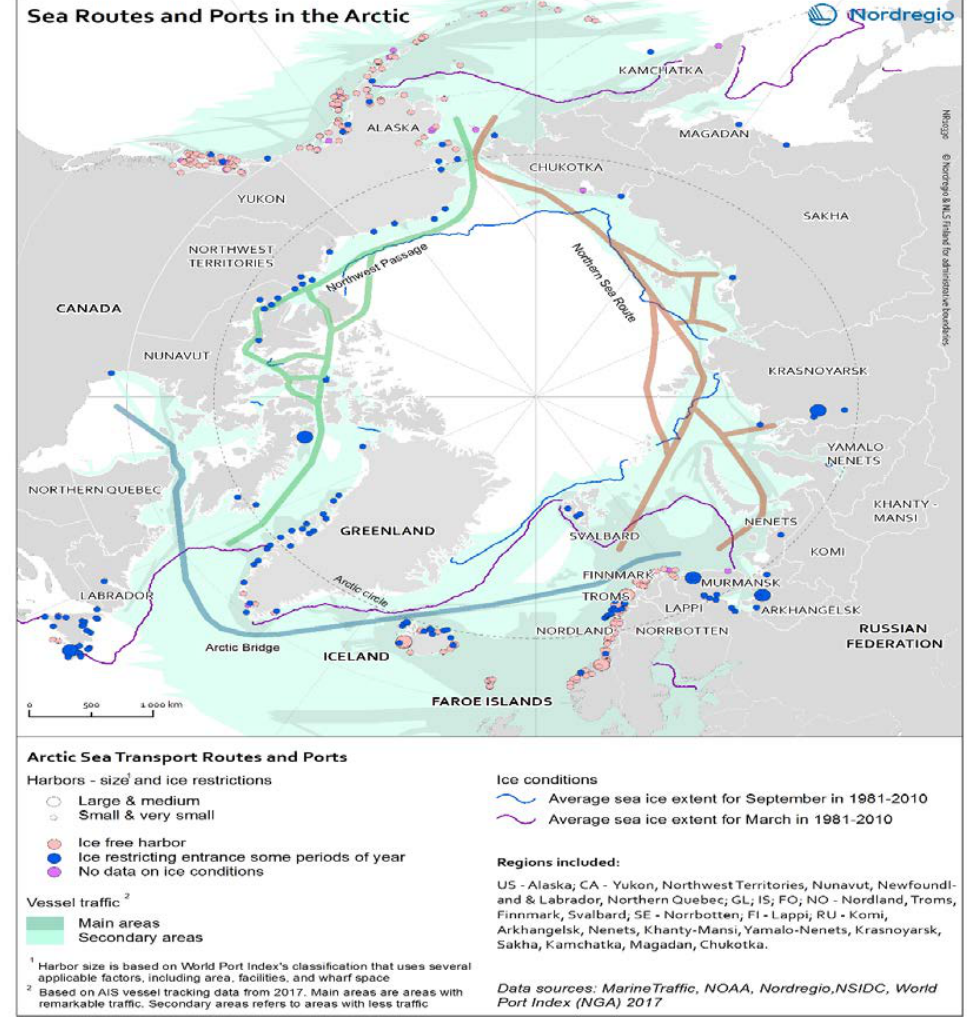
Figure 1. Sea routes and ports in the Arctic. Designer/Cartographer: Eeva Turunen. Courtesy of Nordregio [11].